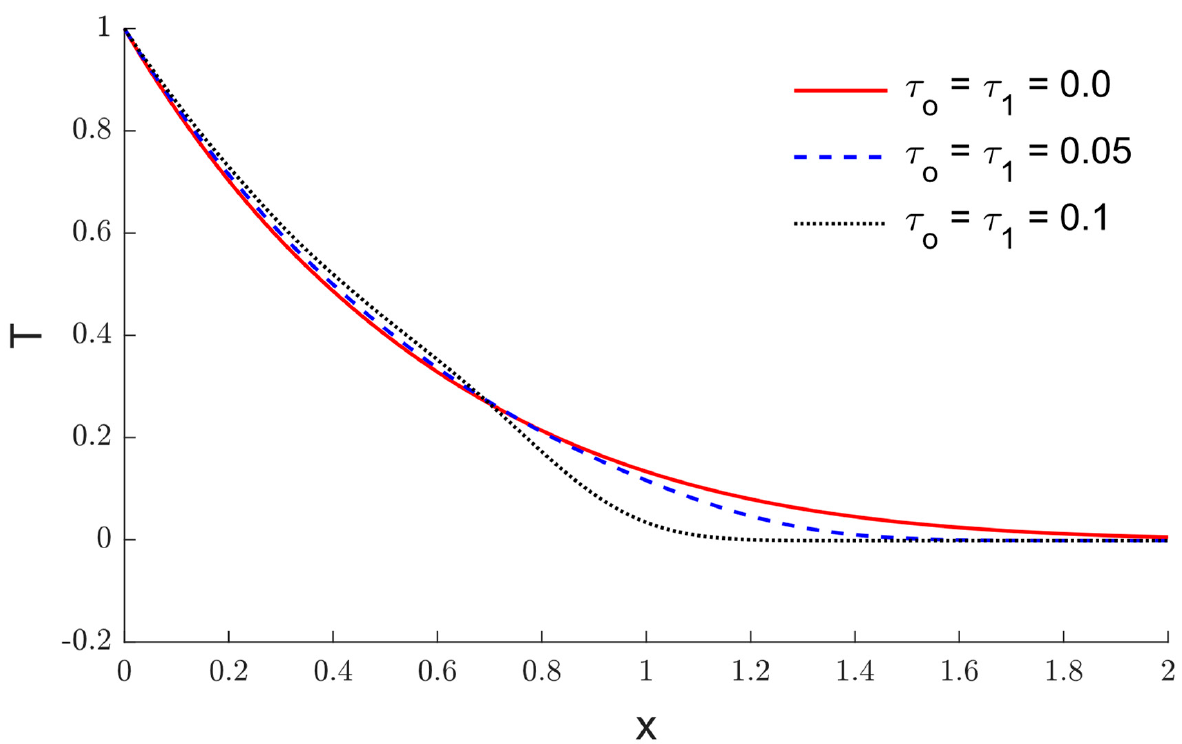
Figure 6. The impact of thermal relaxation times τ o , τ 1 in the temperature variation T via the distance x when K n = 0.5.